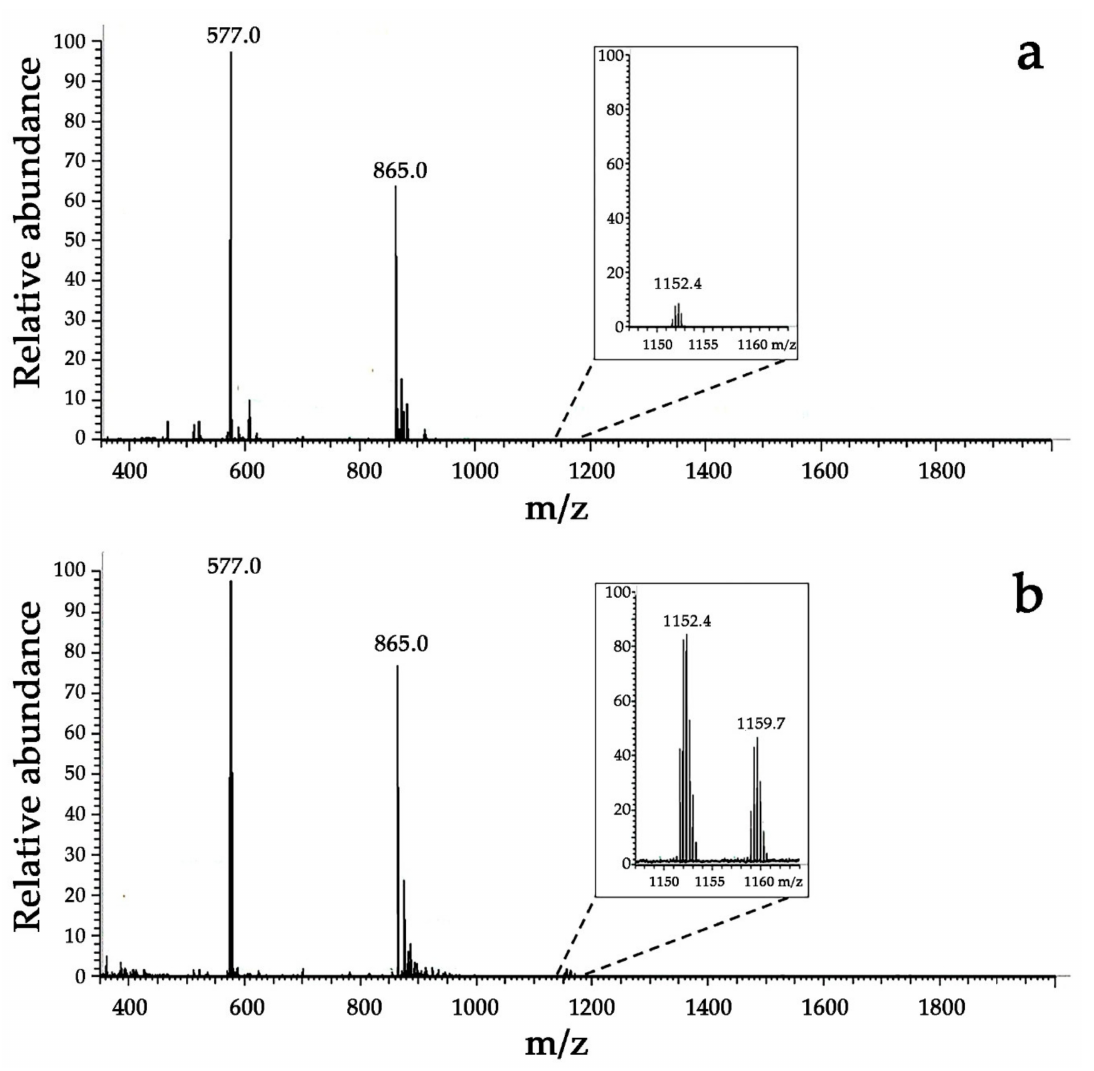
Figure 4. Electrospray mass spectra (in positive mode) of control Hm-AMP2 ( a ) or Hm-AMP2 treated with MPO/H 2 O 2 ( b ) in 10 mM Na-phosphate buffer, pH 7. The concentrations were 40 µ M Hm- AMP2, 0.4 µ M MPO heme, and 50 µ M H 2 O 2 . Peaks at m / z = 577.0 and 865.0 are assigned to the peptide’s triply and doubly charged ions, respectively. Enlargement of the peaks at m / z = 1152.4 and m / z = 1159.7 in ( b ) (inset) vs. the peaks in ( a ) (inset) shows dityrosine cross-linked peptide dimer resulted from the MPO-mediated reaction. Table 2. Disappearance of free sulfhydryl groups in the mixture of cationic antimicrobial peptides (CAMPs) with MPO/H 2 O 2 . The amount of sulfhydryl groups is expressed as a percentage relative to the content in the mixture of CAMP and MPO with no added H 2 O 2 . The concentrations were 150 µ M